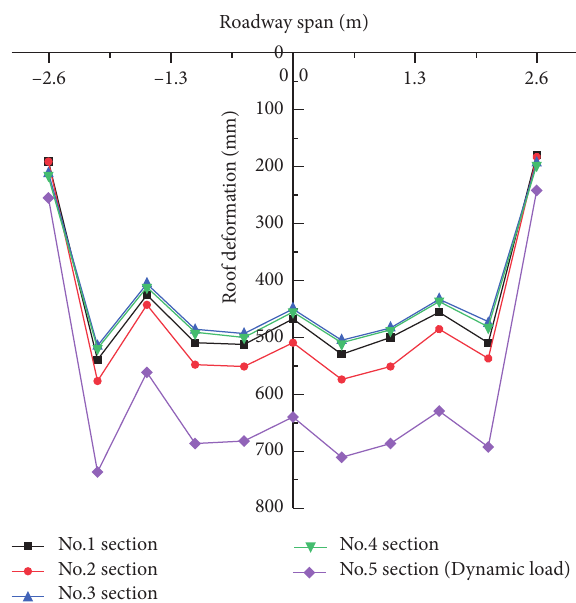
Figure 7: Evolution of roof displacement